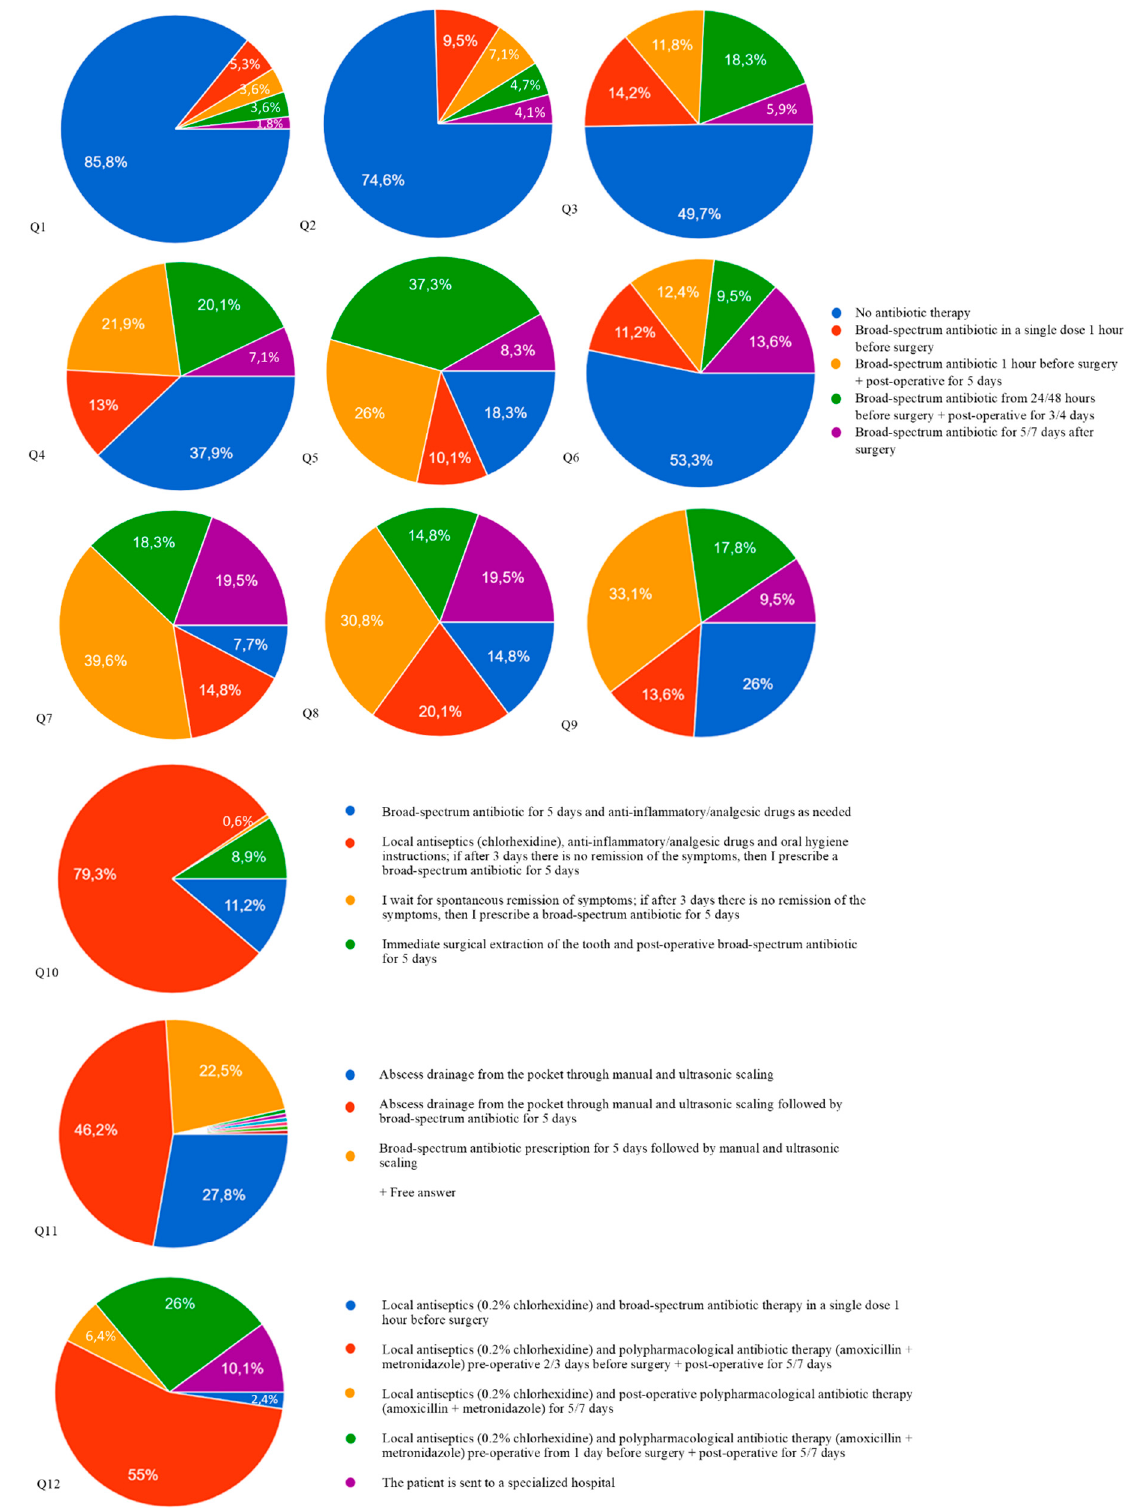
Figure 1. Graphs summarizing responses to specific questions about the use of prophylactic antibiotics to prevent SSI after the most common oral surgical procedures. Percentages are rounded to the first decimal place. The questions are reported in Figure 2.